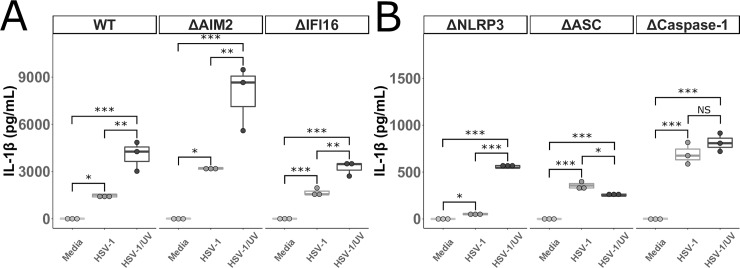
IL-1β produced by THP-1 cells after infection with UV-irradiated HSV-1.A and B. THP-1 cells were stimulated with PMA (5 ng/mL) and then with IFNγ (25 ng/mL) the following day for 24 hours prior to incubation with HSV-1, UV irradiated HSV-1 (HSV-1/UV), or media alone for 24 hours. Cell culture supernatants were collected and IL-1β was measured. ΔHUMCYC cells are labeled as “WT.” Differences between indicated conditions within a cell type were determined by a one-way ANOVA with Tukey HSD post-hoc analysis. NS, *,**,*** indicate p-values >0.05, <0.05, <0.01, <0.001 respectively.